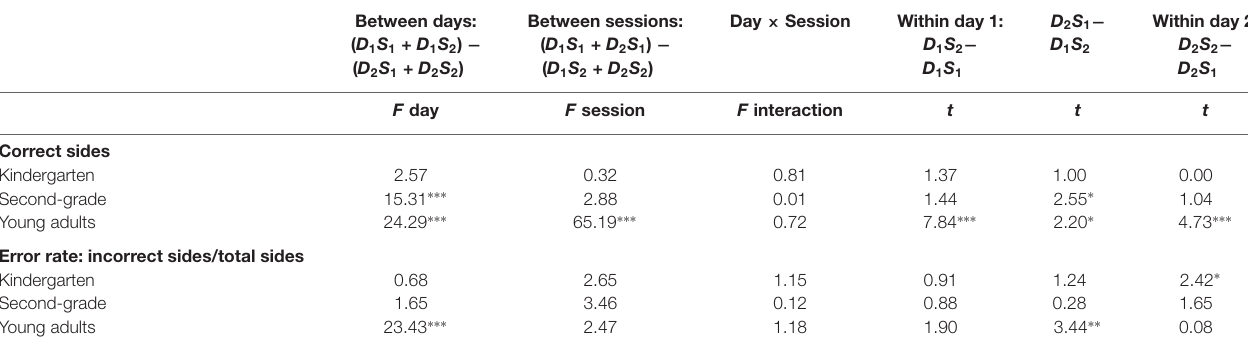
TABLE 1 | Within-group comparison of correct sides and incorrect sides ratio, across sessions and days . Between days: Between sessions: Day × Session Within day 1: D 2 S 1 −